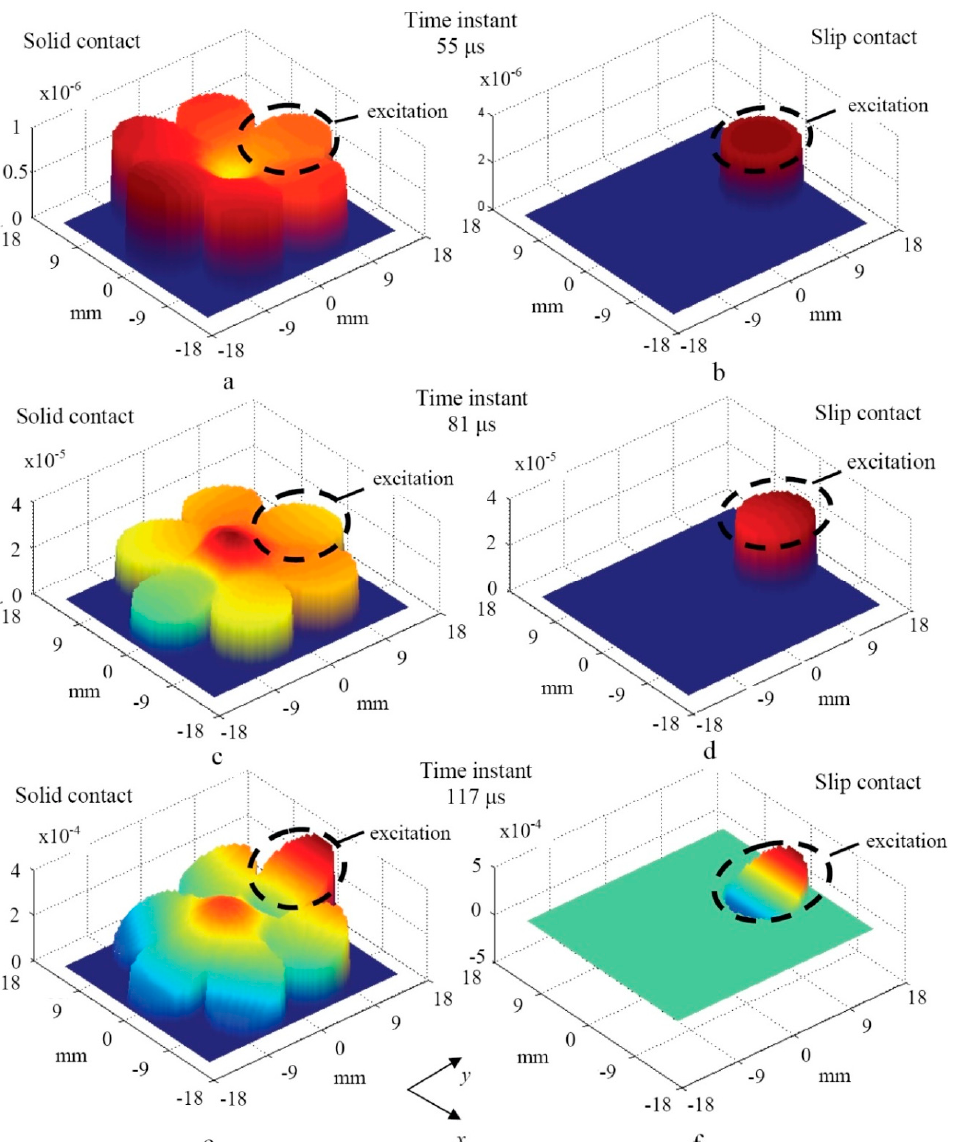
Figure 12. 3D representation of the axial component ( v z ) of the particle velocity (cross-section plane y - x ) at different time instants and acoustic contacts (solid or slip) between adjacent strands: time instant 55 µs (( a ) solid contact, ( b ) slip contact), time instant 81 µs (( c ) solid contact, ( d ) slip contact) and time instant 117 µs (( e ) solid contact, ( f ) slip contact). The excitation was applied to the strand which is marked by a dashed line.